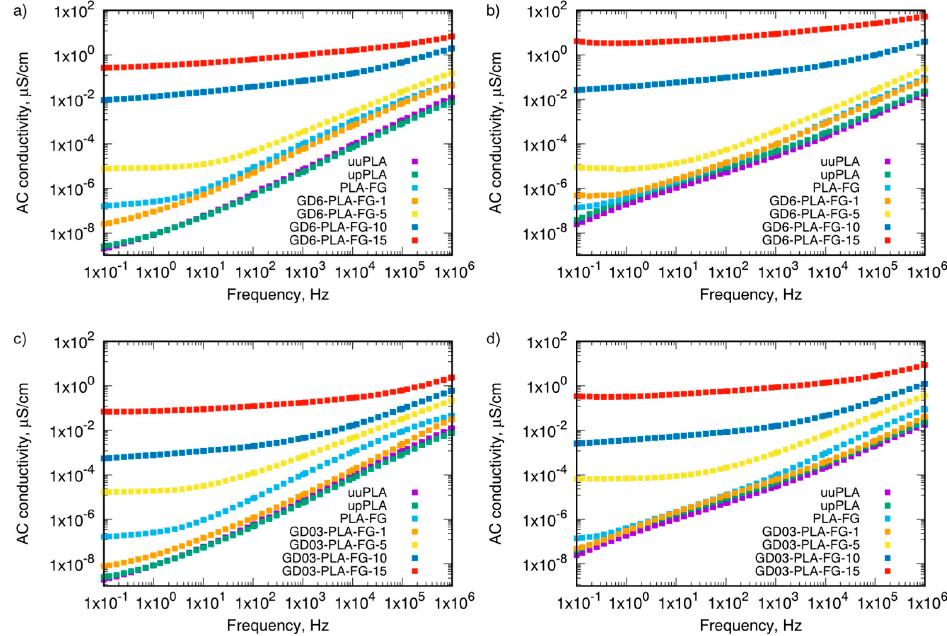
Figure 6. AC conductivity of ( a ) GD6-PLA-FG nanocomposites, and ( c ) GD03-PLA-FG nanocomposites at 298.15 K; ( b ) GD6-PLA-FG nanocomposites, and ( d ) GD03-PLA-FG nanocomposite at 333.15 K. uuPLA—unfilled and unprocessed PLA, upPLA—unfilled and processed PLA, PLA-FG—PLA with plasticizer and compatibilizer, GD6—graphite/diamonod mixture with 6 wt.% ash content, GD03—graphite/diamond mixture with 0.3 wt% ash content, numbers—wt.% of filler (GD6, GD03).